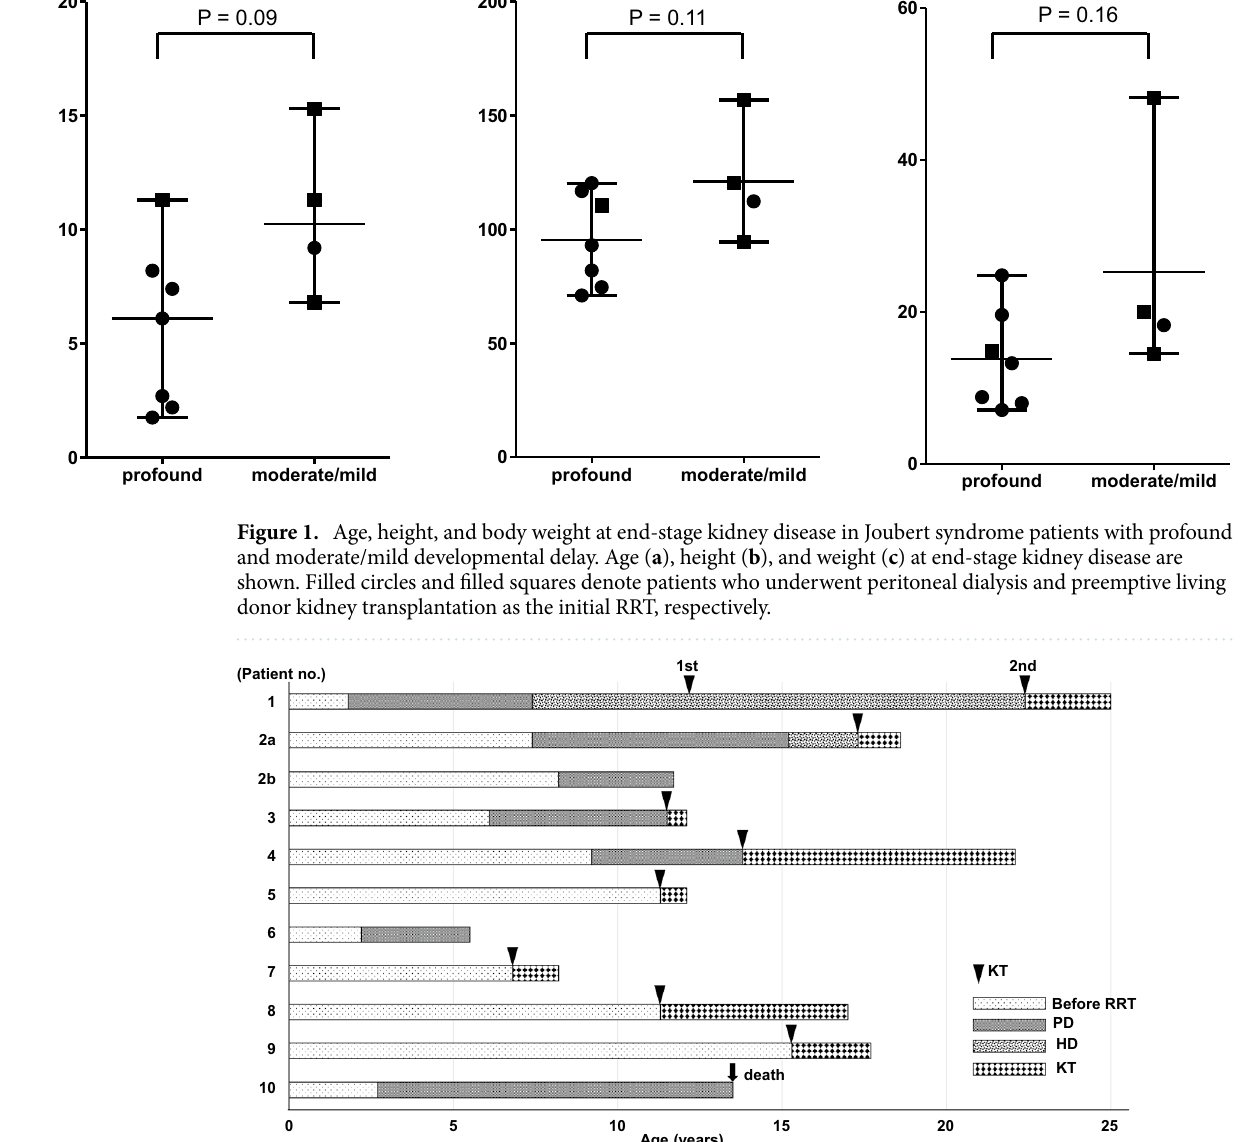
Figure 2. Clinical course of each patient. KT kidney transplantation, RRT renal replacement therapy, PD peritoneal dialysis, HD